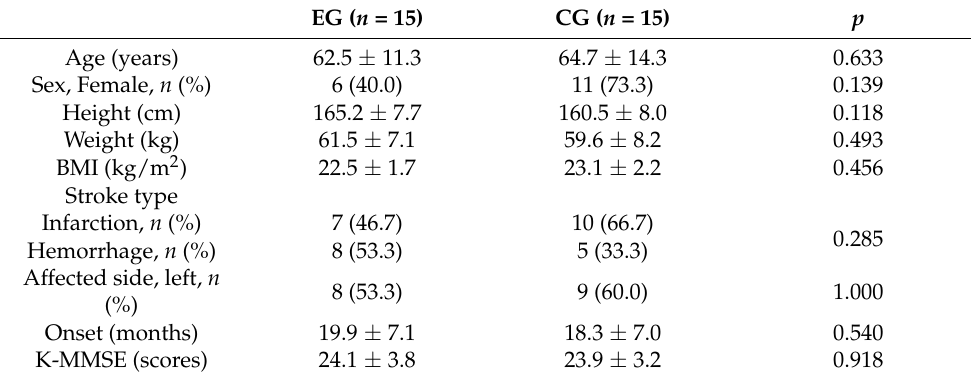
Table 1. General participant characteristics ( n =